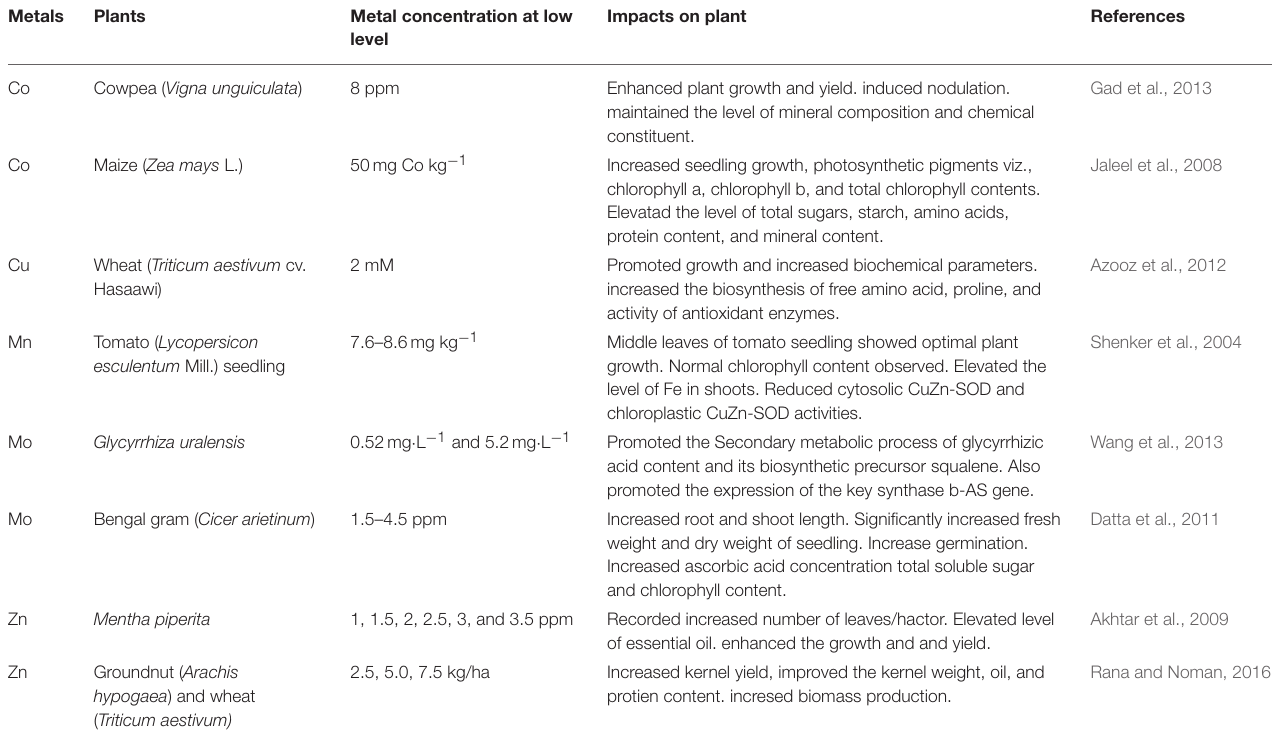
TABLE 1 | Effect of beneficial heavy metal on different plants at low